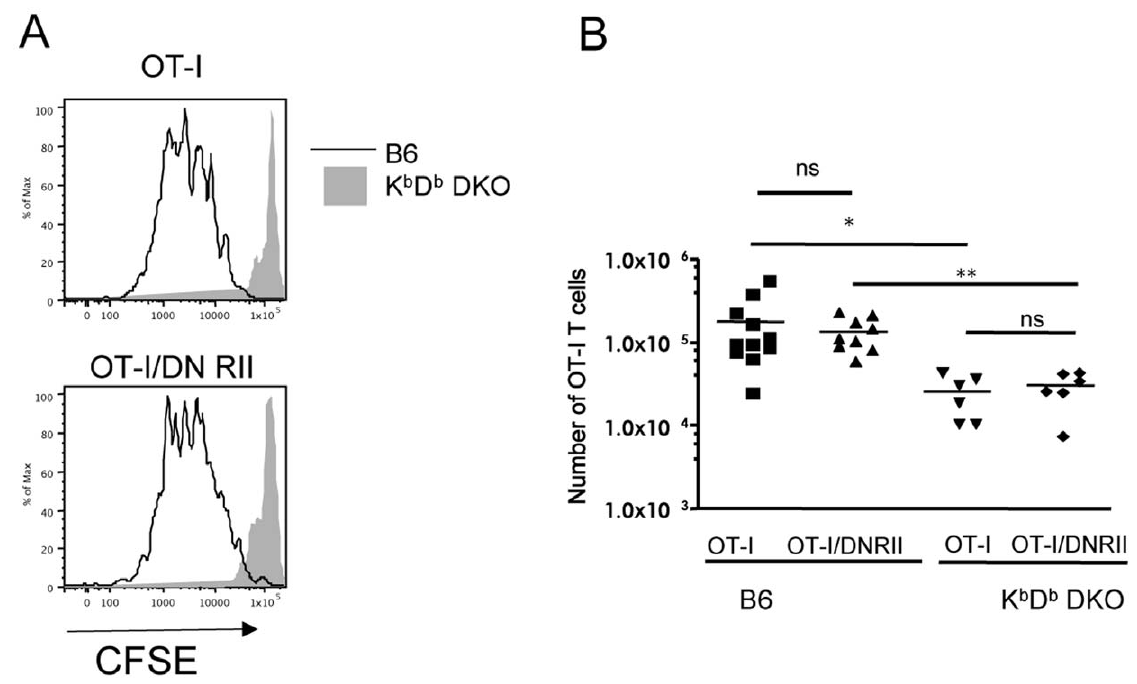
Figure 5. Homeostatic proliferation of OT-I/DNRII is MHC I dependent. CFSE labeled CD44 lo OT-I Rag 2 / 2 or OT-I/DNRII Rag 2 / 2 CD8 T cells were transferred into irradiated K b D b 2 / 2 or wild-type hosts. One week later, lymph nodes and spleen from sacrificed mice were pooled and analyzed. ( A ) Representative CFSE dilution histograms of OT-I and OT-I/DNRII CD8 T cells in pooled lymph nodes and spleen one week after transfer into irradiated B6 and K b D b 2 / 2 hosts. ( B ) Recovery of OT-I and OT-I/DNRII CD8 T cells after one week in irradiated B6 or K b D b 2 / 2 hosts. Each symbol represents an individual mouse. Results are presented as the combination of three independent experiments.